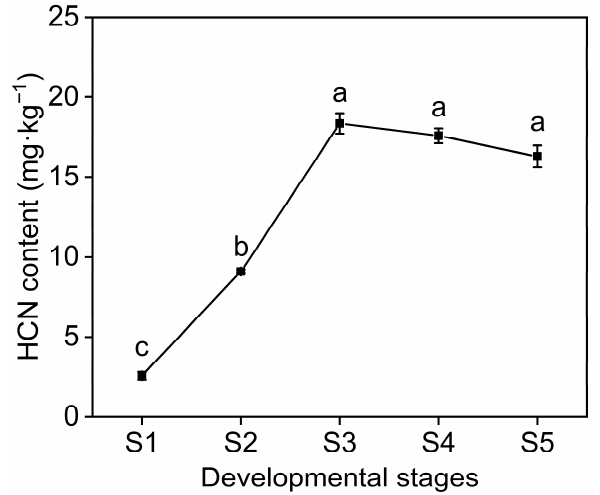
Figure 4. HCN contents in common vetch seeds at different developmental stages. Different letters “a, b, c” indicate significant differences at p < 0.05. S1 to S5 indicate the five developmental stages. Among the DEGs of common vetch seeds at different developmental stages, a total of 745 HCN synthesis-related genes were identified (Table S6). To construct a weighted gene coexpression network consisting of five modules, named green, turquoise, brown, blue and yellow, WGCNA was used (Figure 5A). There were 27, 529, 45, 90, and 41 genes in the green, turquoise, brown, blue and yellow modules, respectively. Another 13 genes in the gray module were excluded (Figure 5B). Further analysis revealed that the correlation coefficients between the modules and HCN content ranged from -0.783 to 0.455. In the five modules, the turquoise module had the highest correlation coefficient with HCN content and was significantly correlated ( p < 0.001), suggesting that the turquoise module plays a major role in HCN synthesis (Figure 5B). A correlation analysis between the module membership (MM) and gene significance (GS) of the five modules was performed, in which a significant correlation between MM and GS of the turquoise module was found ( R = − 0.940, p = 3.13 × 10 − 257 ) (Figure S4). In the turquoise module, genes with high MM tended to have high GS, and GS and MM exhibited a very significant correlation, implying that genes of the turquoise module also tend to be highly correlated with